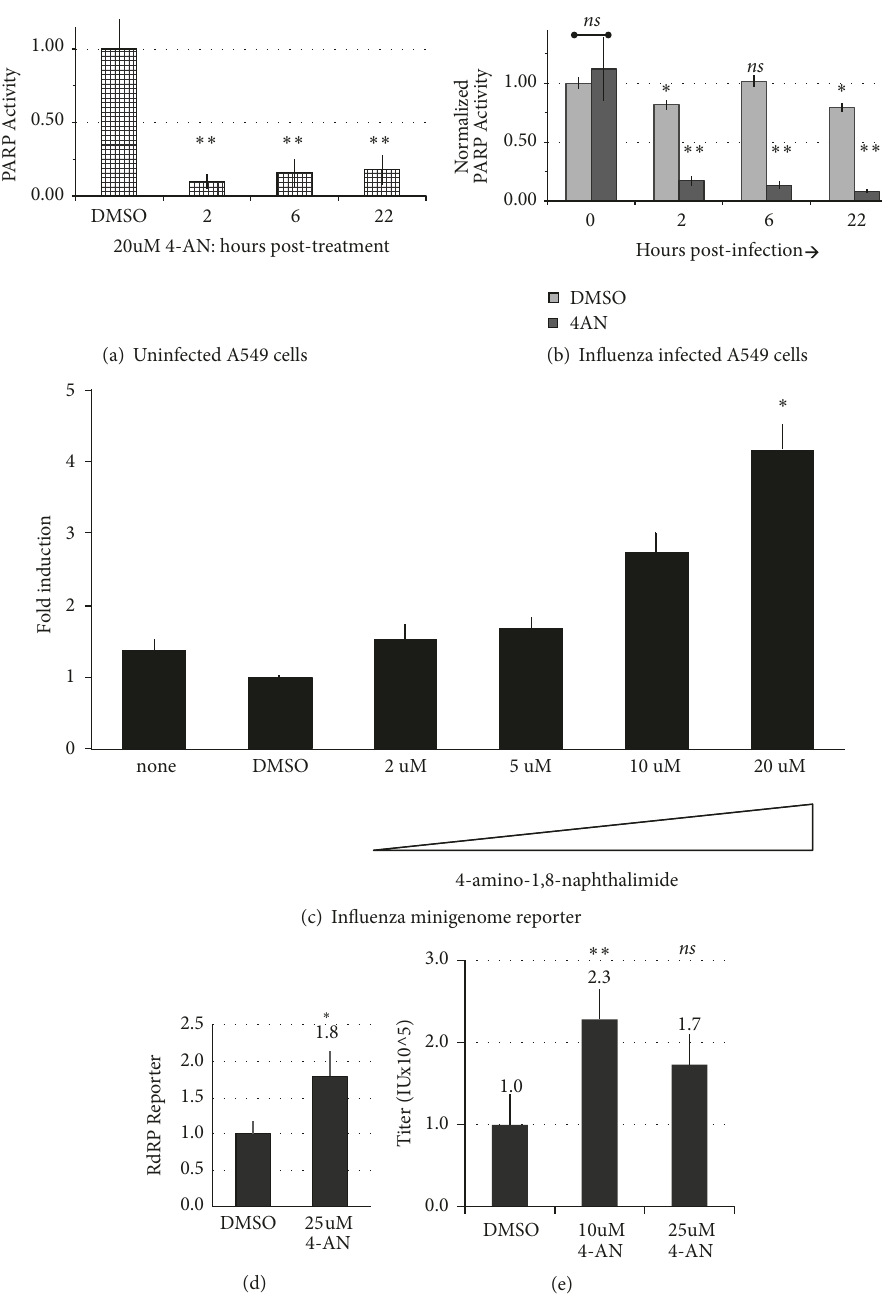
Figure 3: Inhibitor of PARP1/2 proteins PARylation activity increases IAV RDRP activity . (a) Assay of cellular PARylation after treatment by 4-amino-1,8-naphthalimide (4-AN) for 20h in A549 cells. (b) Poly-ADP ribosylation (PARP) enzymatic activity was analyzed in protein lysates from A549 cells treated with DMSO vehicle, 20uM 4-AN, or 1uM doxorubicin (DOXO), and infected 20h with IAV (A/PR/8/34 H1N1, MOI = 1); lysates were analyzed by PARylation assay. (c) HEK 293T cells were transfected with NP and polymerase cDNA plasmids in IAV minigenome reporter assay and untreated, treated with vehicle (DMSO), or increasing doses of PARP inhibitor drug (4-AN). (d) HEK 293T cellsweretransfectedwithRdRPfireflyluciferasereporterconstructonedaypriorvehicle(DMSO)ortreatmentwith25uM4-ANandinfected with low-path, H5N1 HALo virus (MOI = 1). Infected cell viral polymerase activity was analyzed after 20h by luciferase assay; two-tailed t- test ( ∗ ) p =0.06. (e) Single-step growth of H5N1 HALo virus (MOI = 1) in A549 cells pretreated with 4-AN or vehicle (DMSO) as indicated. Infectious titer (IU) released 1d.p.i. measured by limiting dilution assay for NP-positive cells. Two-tailed t-test for significance in comparison to vehicle: ∗∗ , p < 0.05; ns, not significant. All experiments were performed in biological duplicates with two readings per